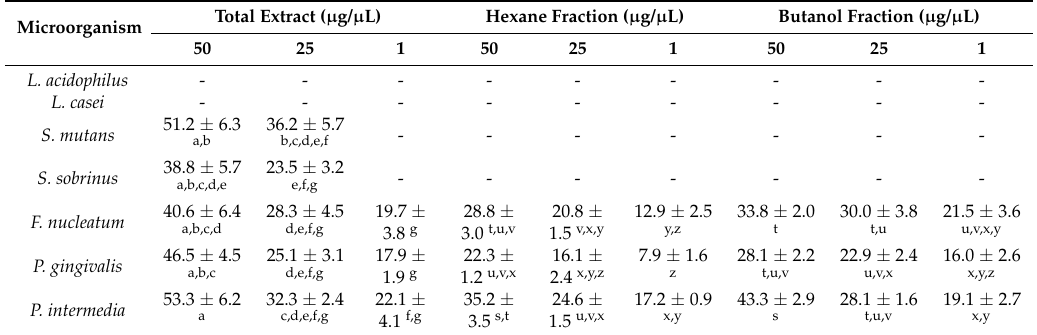
Table 2. Antimicrobial activity from total extract and bioactive fractions from Berberis goudotii ( µ g/ µ L) *.